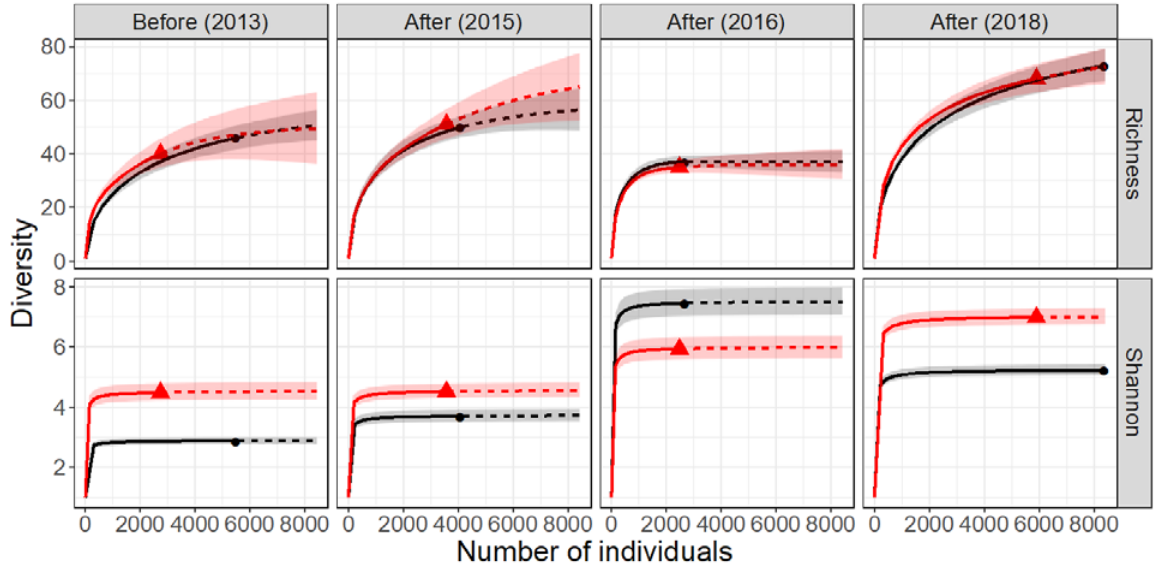
Figure 6. Sample-size based rarefaction (solid line segment) and extrapolation (dotted line segments) diversity curves for benthic assemblages in the control (black) and impact (red) reach of the River Lambourn pre and post restoration. The shaded areas represent 95% confidence intervals.